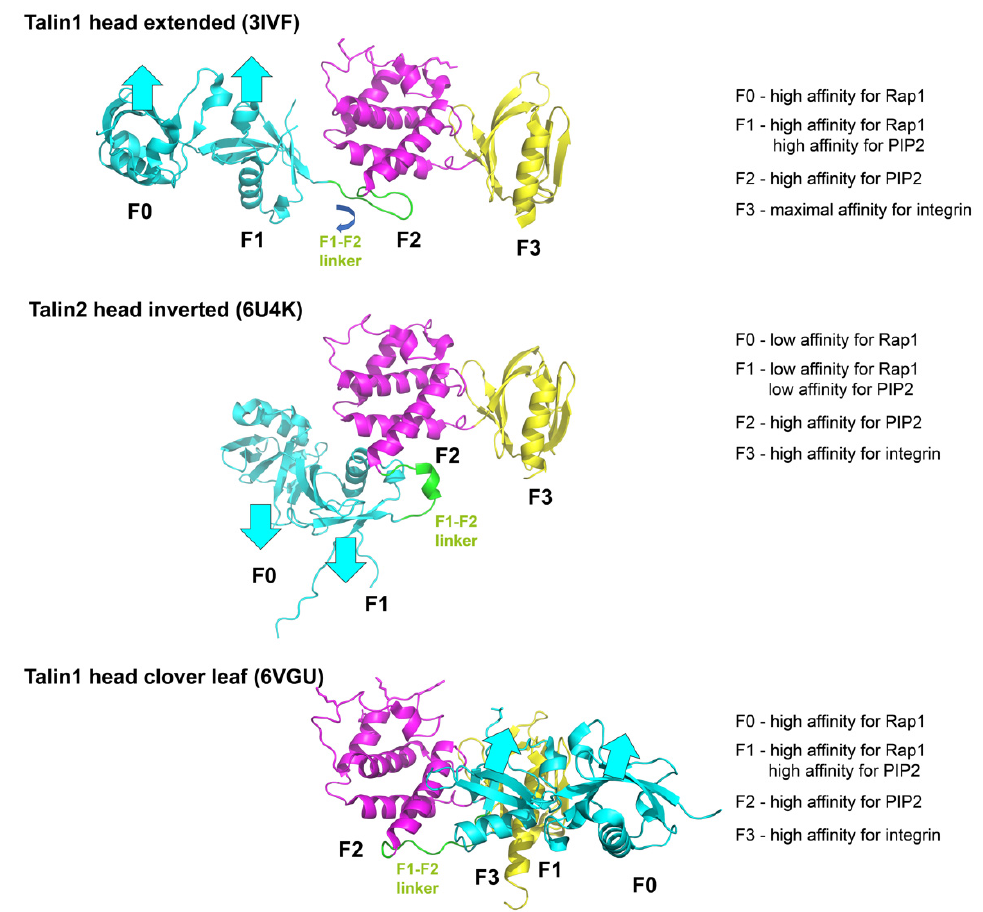
Figure 2. A model of dynamic regulation of integrin activation states by talin head. Upper panel: Talin-1 head extended conformation. The F0F1 subdomains (cyan) facing the plasma membrane have high affinity for Rap1. F1 and F2 (magenta) have high affinity for PIP2. F3 (yellow) has maximal affinity for integrin. Middle panel: Talin-2 head inverted conformation. The F0F1 subdomains are inverted, away from the membrane, with low affinity for Rap1 and PIP2. Lower panel: Talin-1 head cloverleaf conformation. The F0F1 subdomains facing the plasma membrane have affinity for Rap1 and PIP2; F3 has high affinity for integrin.